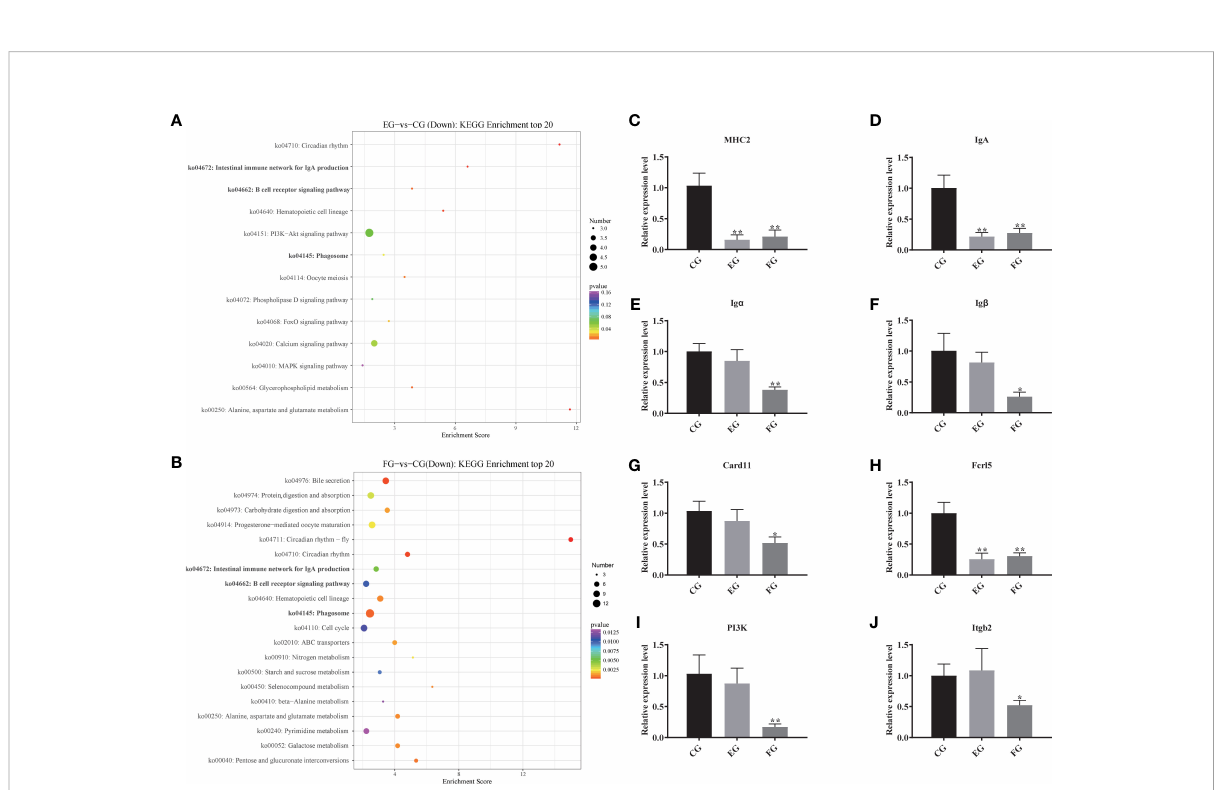
FIGURE 5 Pathway enrichments of all DEGs related to immune function. (A, B) The most enriched KEGG pathways of all DEGs in response to antibiotic groups in the intestine of grass carp compared with the control group. (C – J) Immune genes expression levels of MHC2 , IgA , Ig a , Ig b , Card11 , Fcrl5 , PI3K and Itgb2 mRNA in the intestine of grass carp fed with the control and antibiotic diets for 2 weeks. The different symbols show signi fi cant differences (*, p < 0.05; **, p < 0.01).